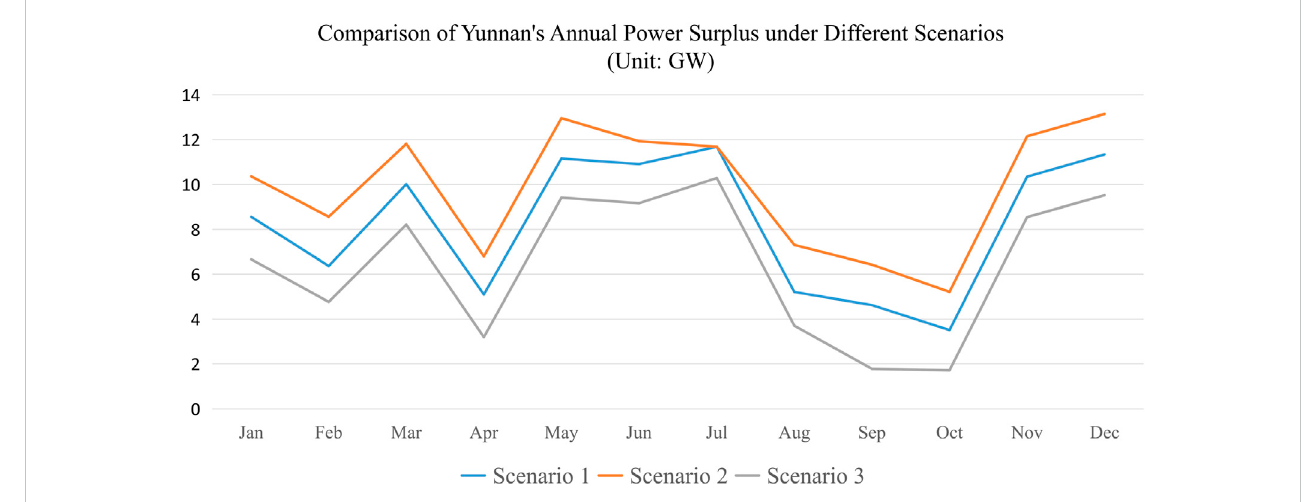
FIGURE 7 Comparison of Yunnan ’ s annual power surplus under different scenarios.